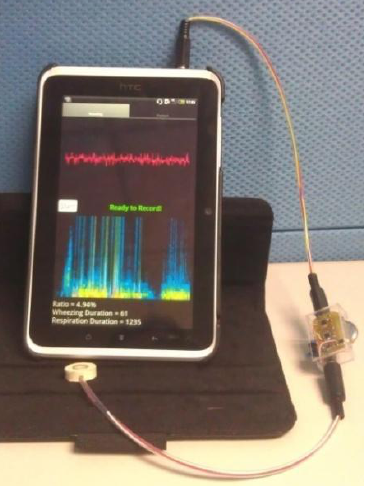
preprocessing circuit, and respiratory sound analysis program based on RSACC program. Analysis program runs on android OS